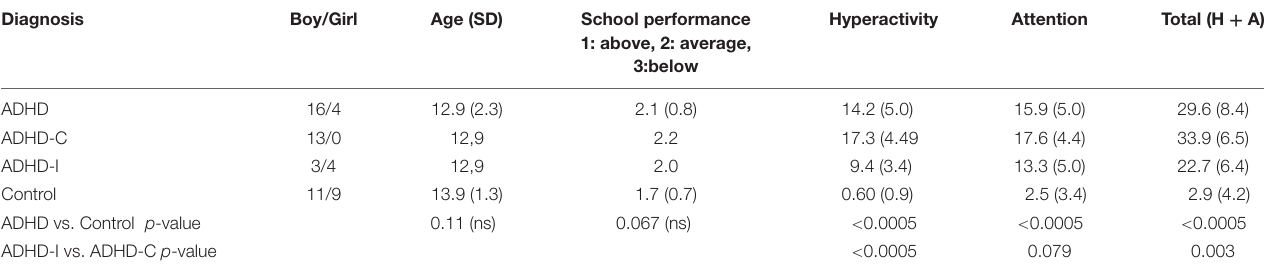
TABLE 1 | Participants’ characteristics: Teachers’ assessments of school performance, of inattention, and hyperactivity on the SNAP score. Diagnosis